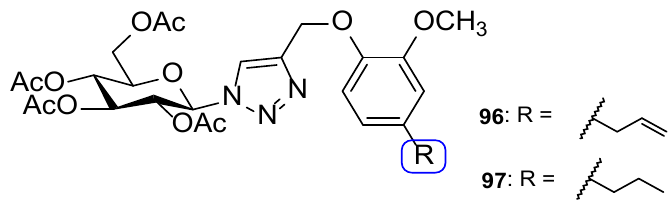
Figure 47. Chemical structures of compounds 96 and 97 [131].